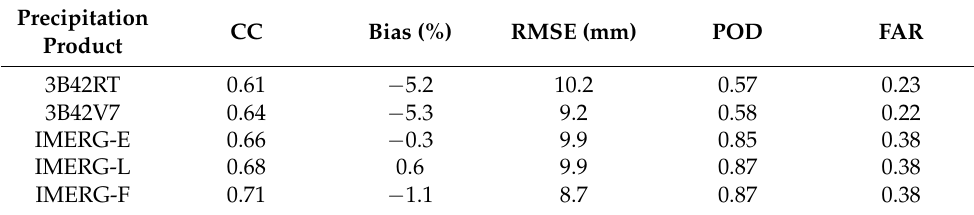
Table 1. Accuracy of the evaluation metrics for the five SPPs in the Mishui Basin.